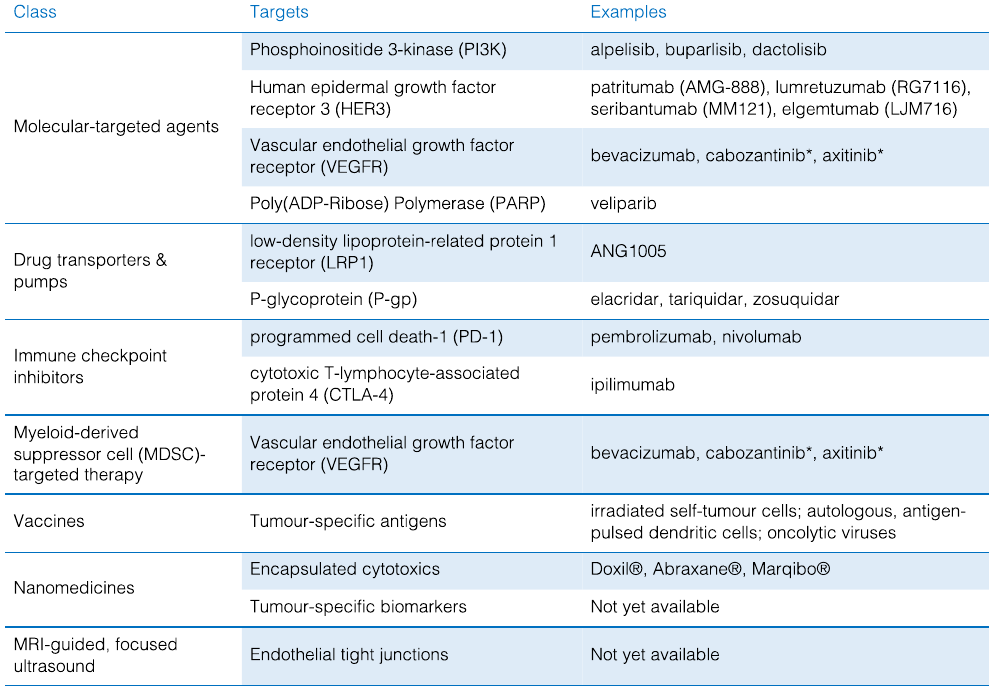
Figure 3. Summary of the approaches discussed in Section 4, including therapeutic classes, their molecular targets and examples of experimental or clinically approved molecular targets and examples of experimental or clinically approved agents.